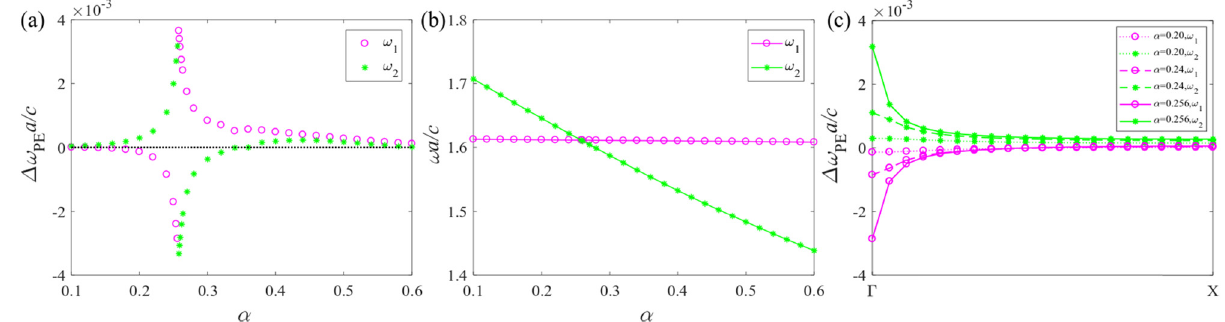
Figure 6: When two PTC defect modes are coupled with the second PNC defect mode, ( a ) their normalized frequency shift and ( b ) their unperturbed frequencies versus the relative increment α of the defect layer thickness, and ( c ) their normalized frequency shift versus the wavenumber in fi rst irreducible Brillouin zone for di ff erent α